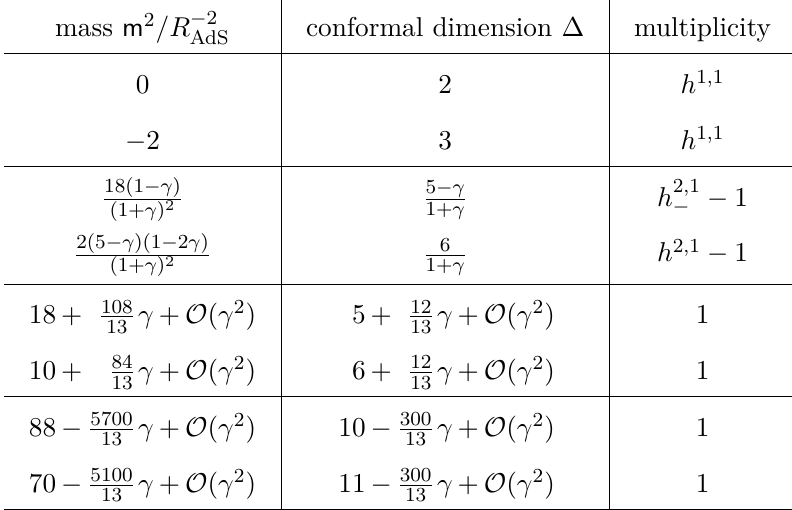
Table 2 . Masses and conformal dimensions for the mirror-dual of the type IIA DGKT setting. In the strict large-complex-structure limit γ = 0 and one obtains integer-valued conformal